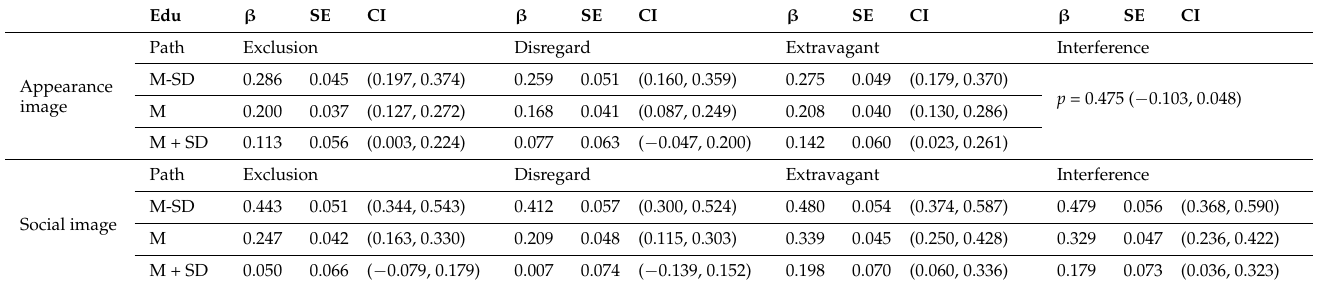
Table A5. Direct effects at different levels of education.